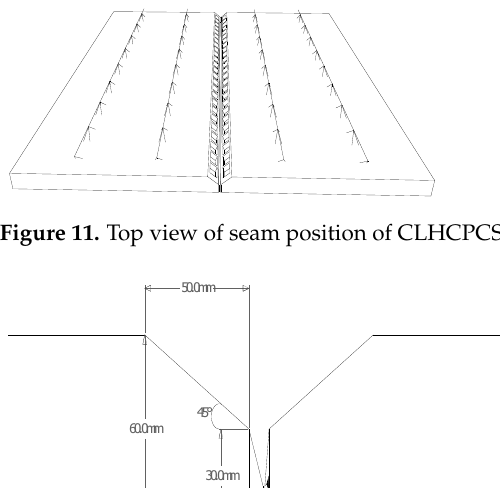
Figure 13. Schematic diagram of the seam of CLHCPCS size. 3.4. Test Data Collection The strain gauges and displacement gauges are arranged as shown in Figures 14–16. During the test, the cracks at each stage, their development and width were carefully ob- served. After the test, the results were analyzed and sorted out to plot the deflection − load curves of composite slab cracks.